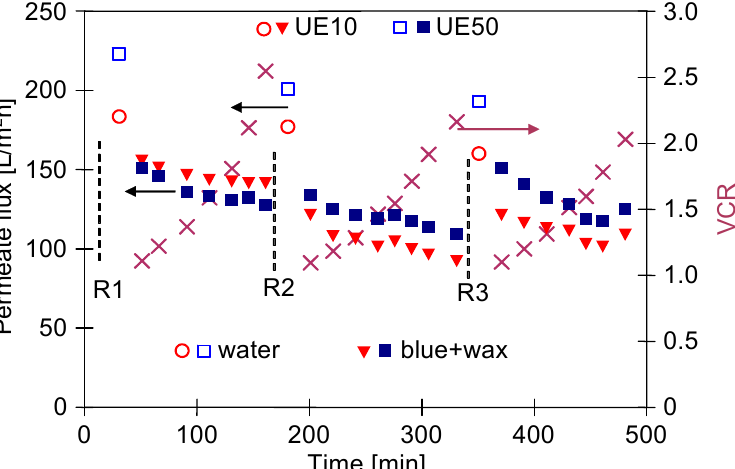
Figure 13. Changes in the permeate flux and VCR during the UF process with continuous permeate collection. Feed: the blue+wax mixture, periodic rinsing with green solution (point R1, R2-60 min) and R3 (120 min).